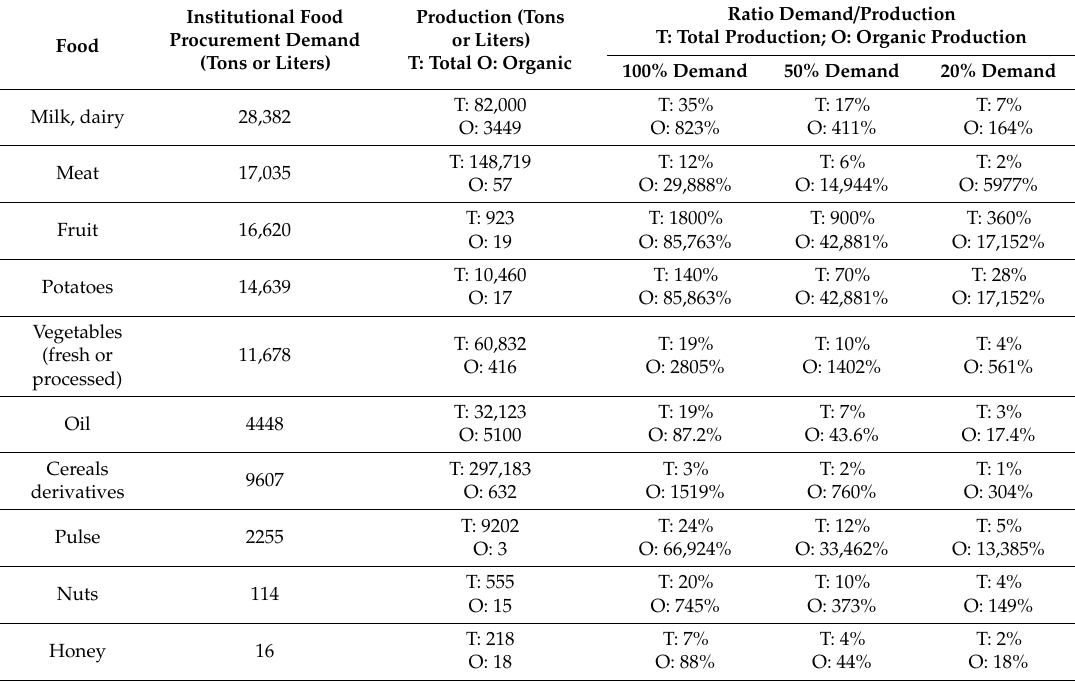
Table 2. Comparison of food demand from institutions and supply capacity in the Comunidad de